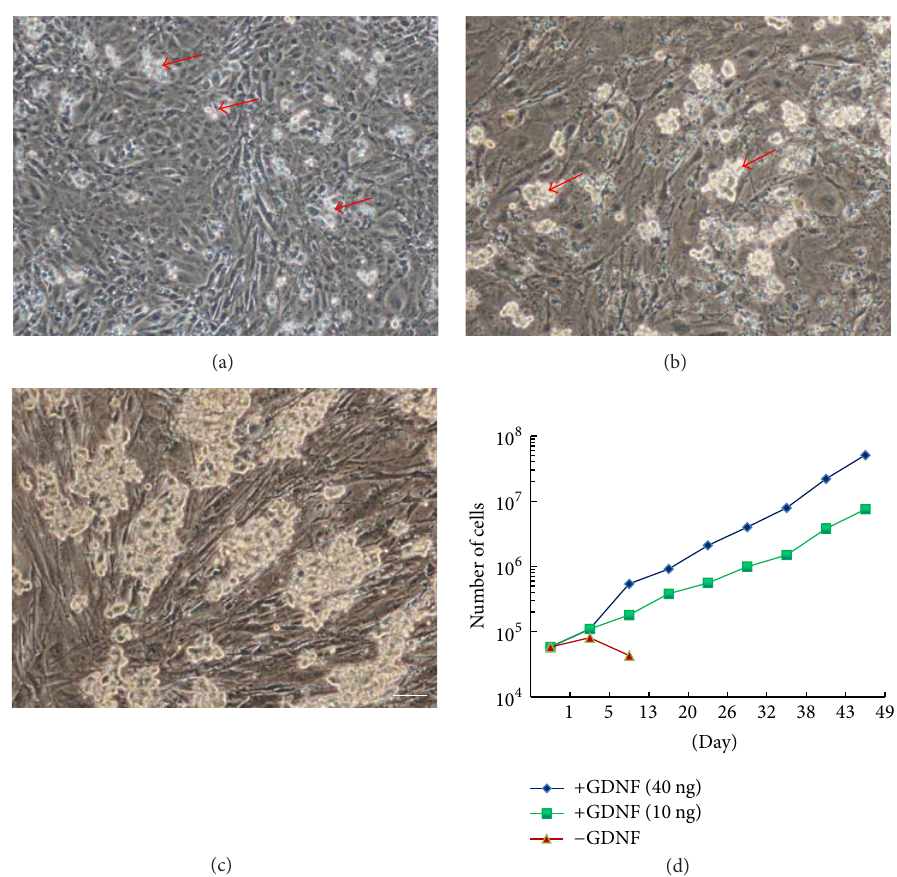
Figure 1: Establishment of mouse spermatogonial cultures in vitro . (a) Single spermatogonium or small spermatogonial clumps (red arrow) were observed 36 hours after culture in vitro . (b) At Passage 3 (P3), cells began to form stable colonies (red arrow) on MEF. (c) Spermatogonial clumps formed on MEF at day 180 in vitro . (d) Proliferation curves of spermatogonial cultures. Within 7-week period, spermatogonia expanded approximately 750-fold with 40ng/mL GDNF and 500-fold with 10ng/mL GDNF. Scale bar: 20 𝜇